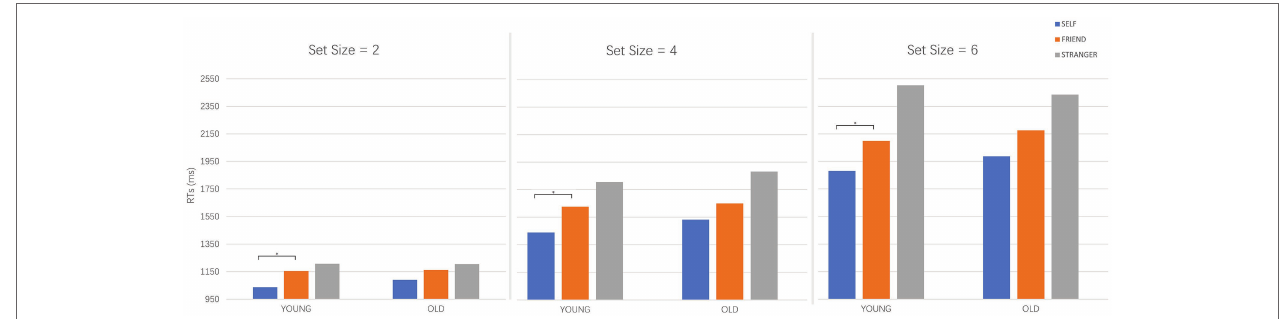
FIGURE 2 | The mean reaction times of the present face and old face for the self, friends, and strangers in the two, four, and six faces set sizes. During the present condition, self-face was responded to significantly faster than the friend-face; while in the old condition, the reaction time for the self-face was not significantly different with the